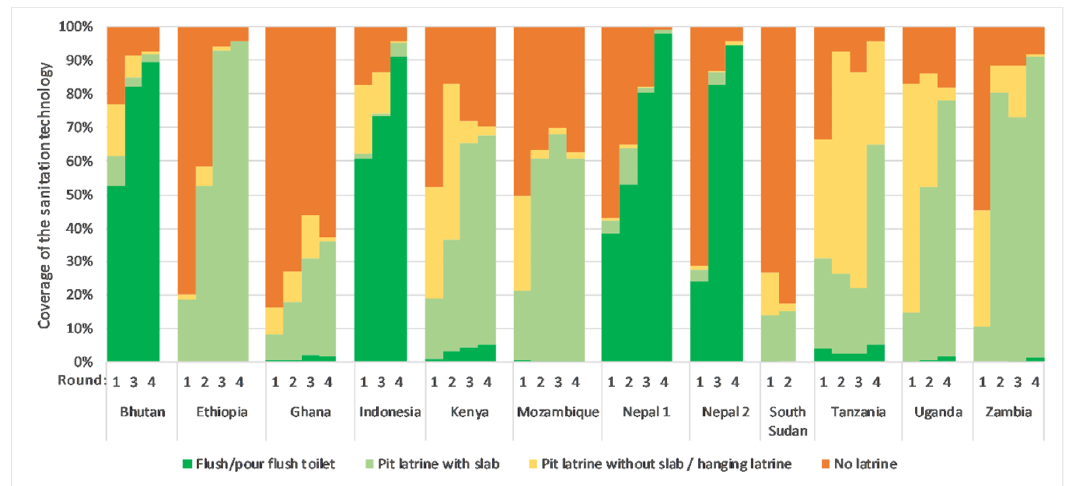
Figure 1. Shift in the coverage of various sanitation technologies across the four rounds.